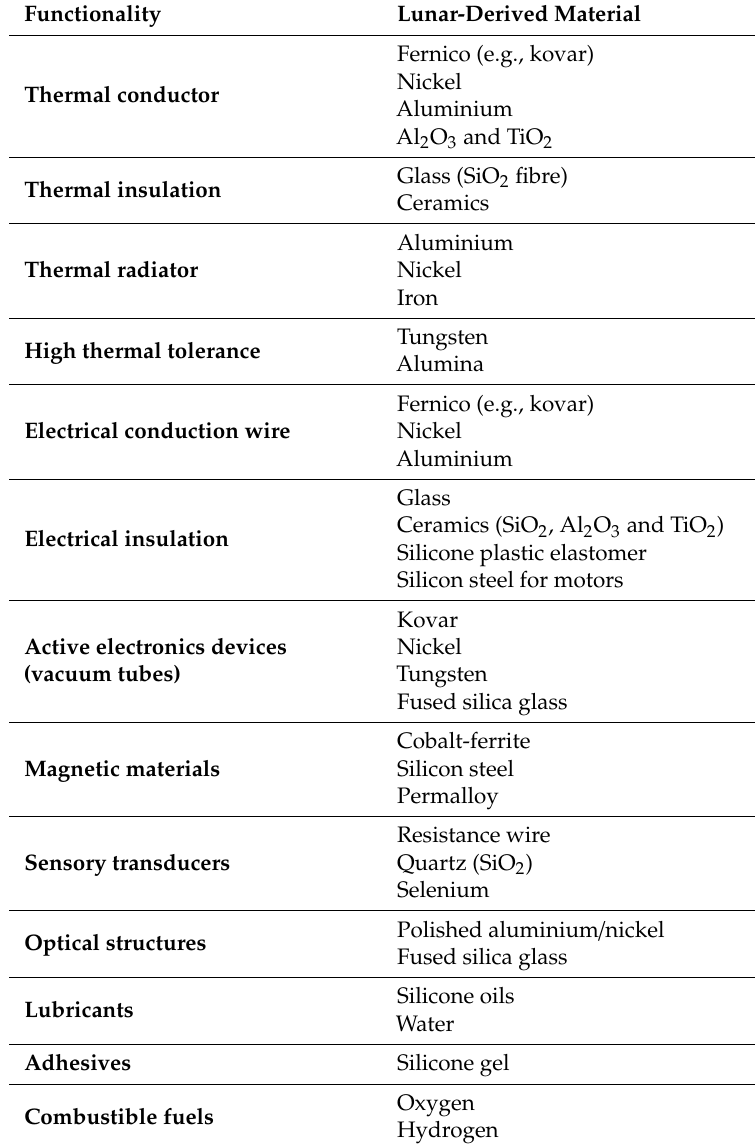
Table 3. Lunar demandite for constructing robotic